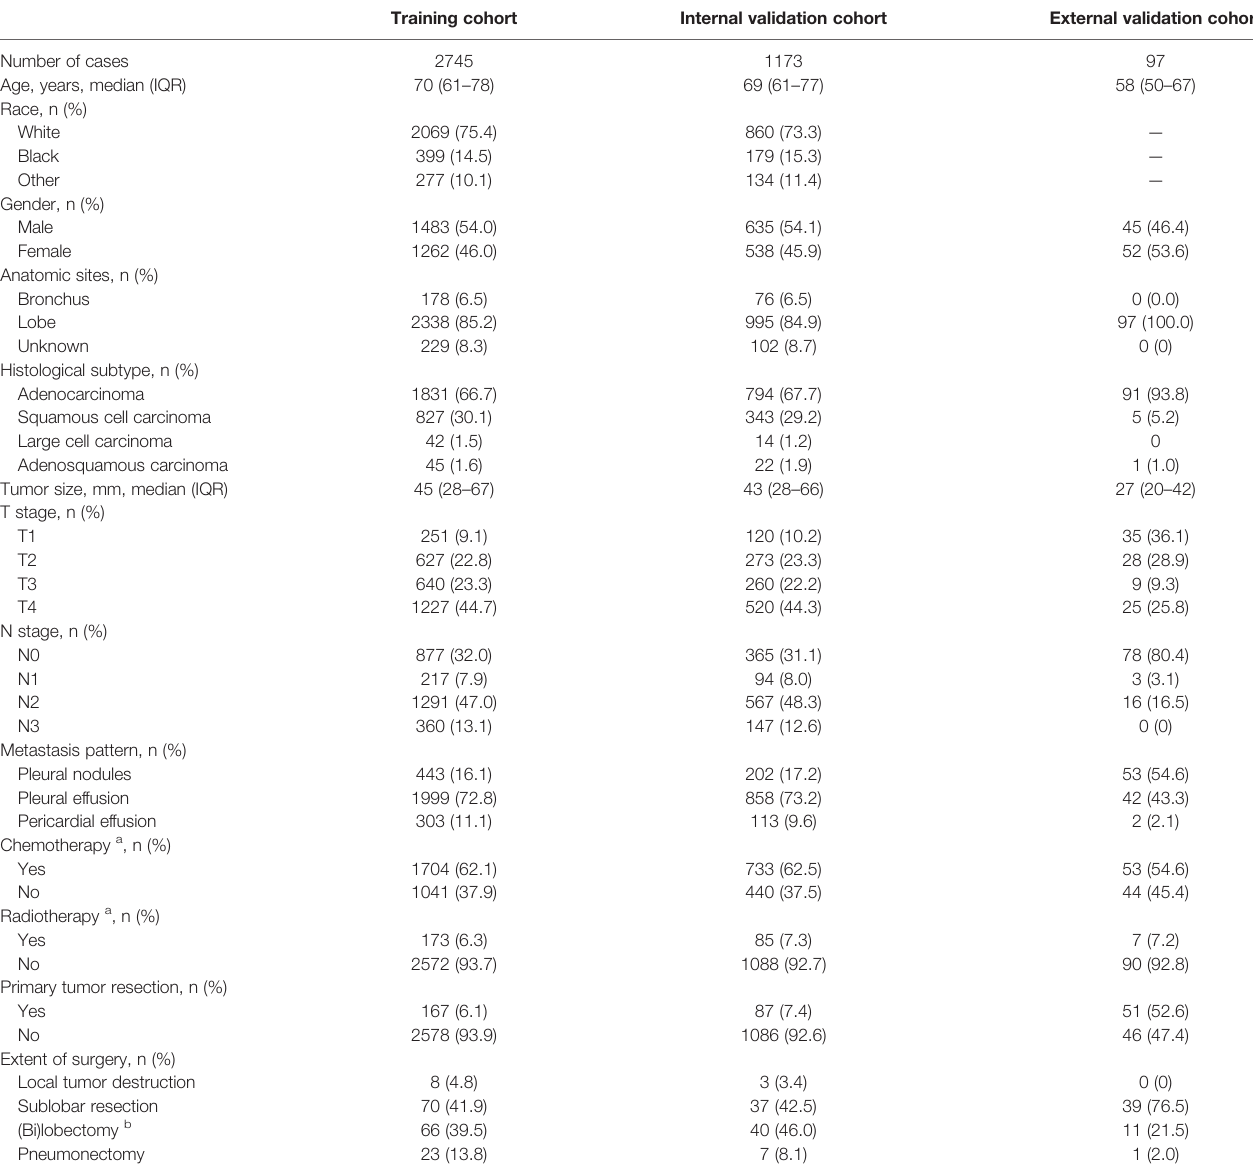
TABLE 1 | Baseline clinicopathological characteristics and treatment information of all, training, and validation